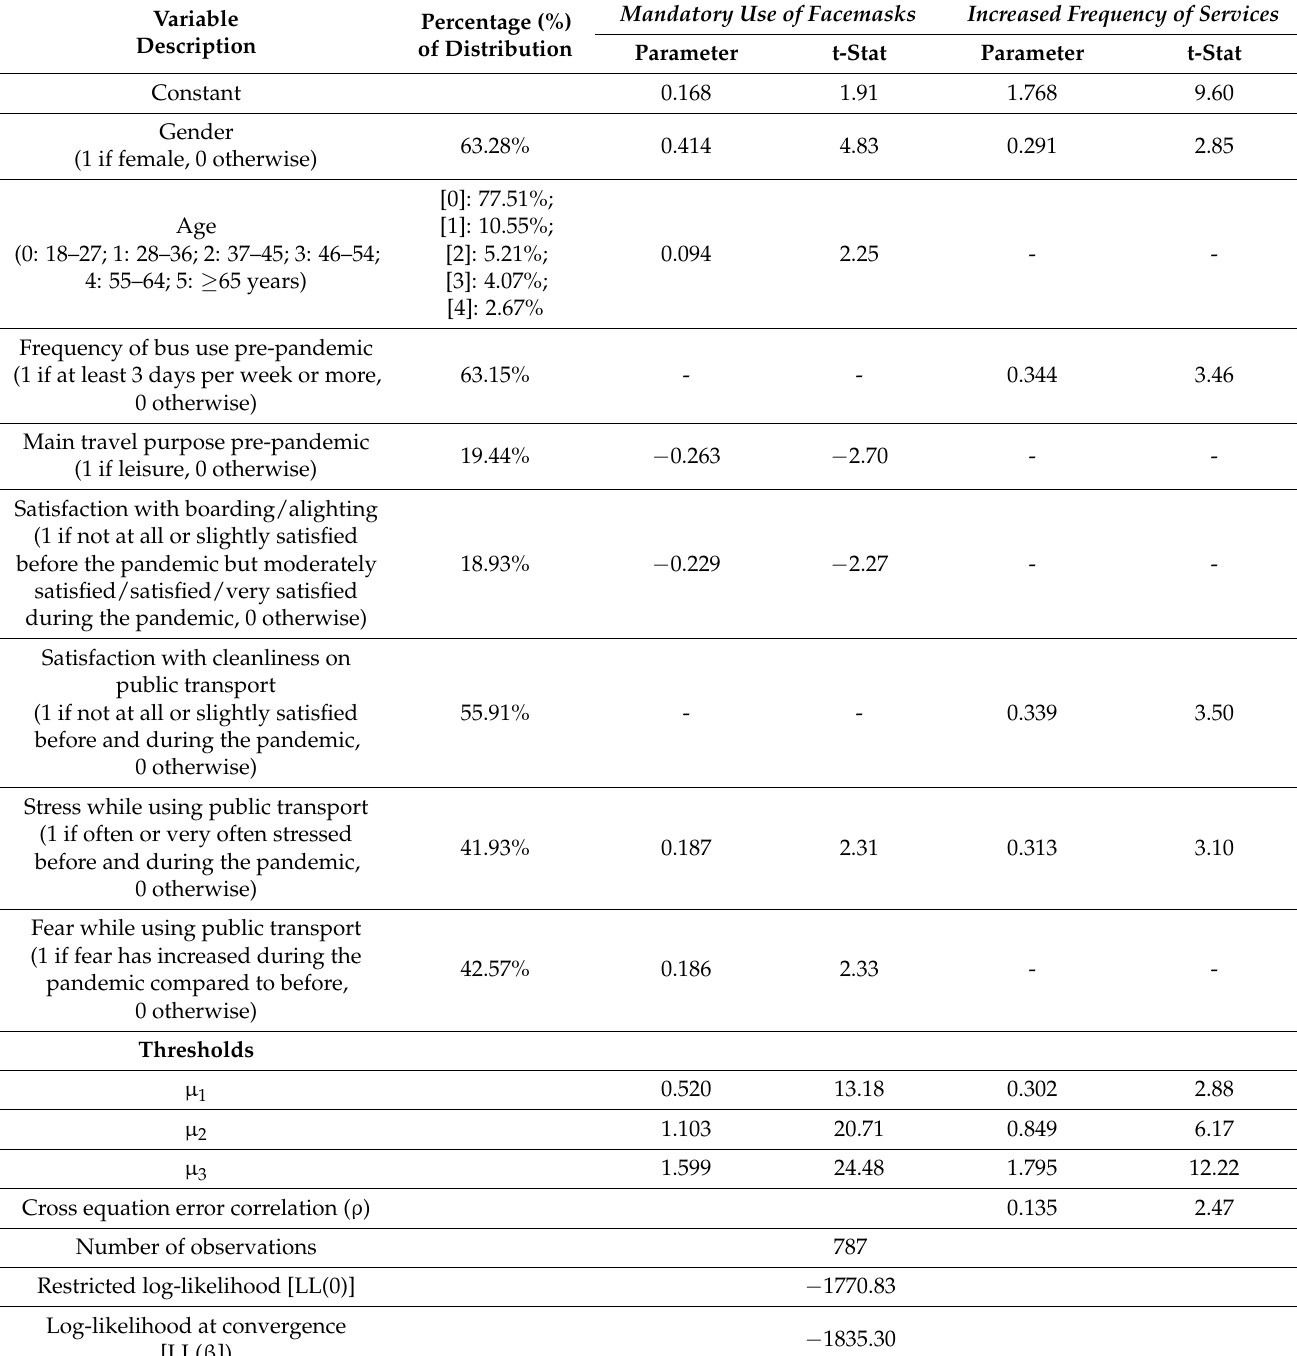
Table 4. Estimation results of the BOP model for attitudes towards policy measures on public transport